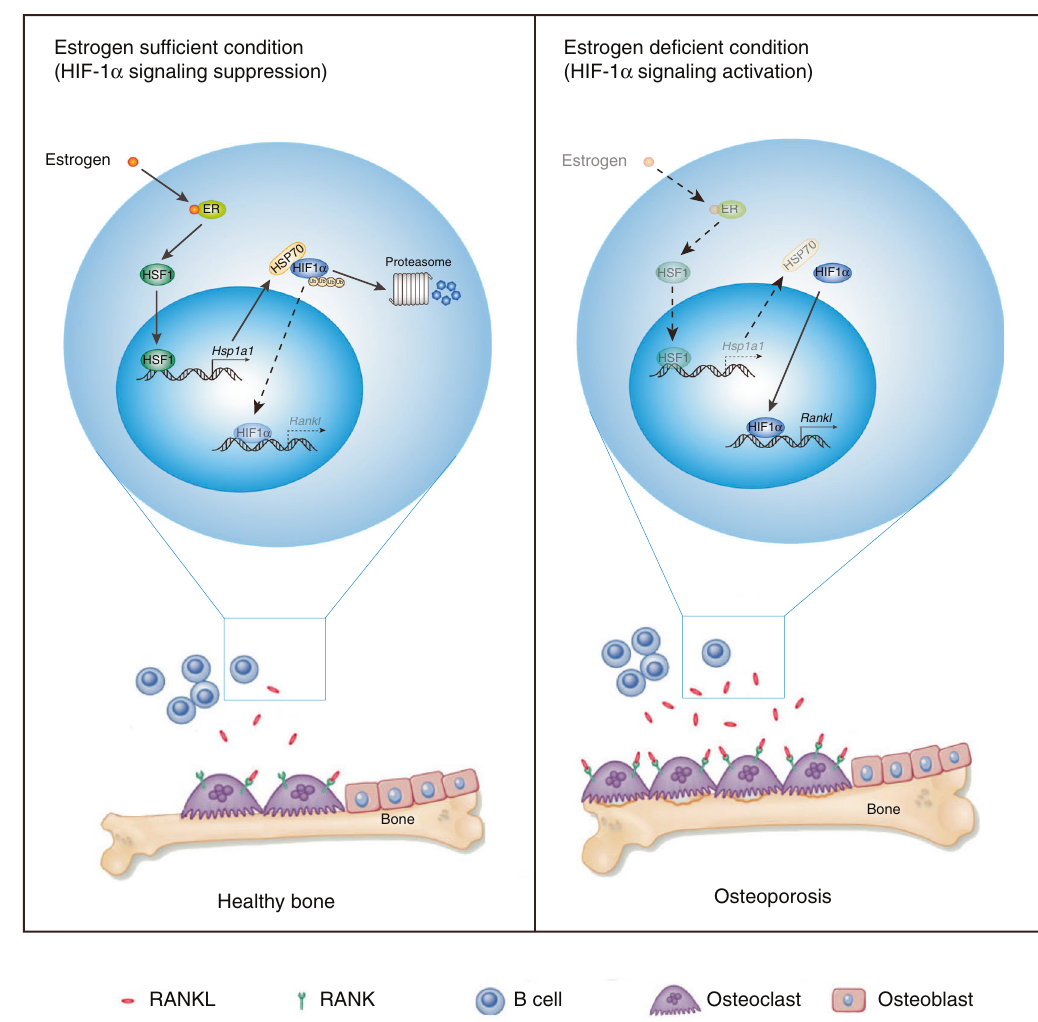
Fig. 7 HIF-1 α signaling in B lymphocytes regulates bone homeostasis through RANKL-mediated